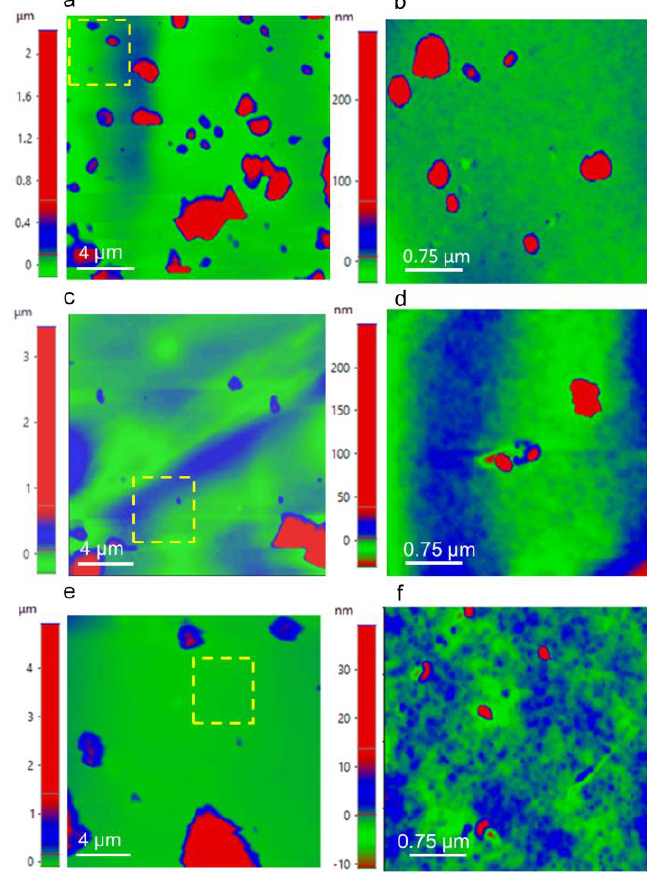
Figure 7. Atomic force microscopy (AFM) micrographs of Fe 3 O 4 @ Sargassum ( a , b ), Fe 3 O 4 @ Sargassum @EDTA ( c , d ), and Fe 3 O 4 @ Sargassum @EDTA ≡ Hg 2+ ( d , e ). The delimited area in panels ( a , c , e ) (dashed lines) corresponds to the magnification zone of panels ( b , d , f ).